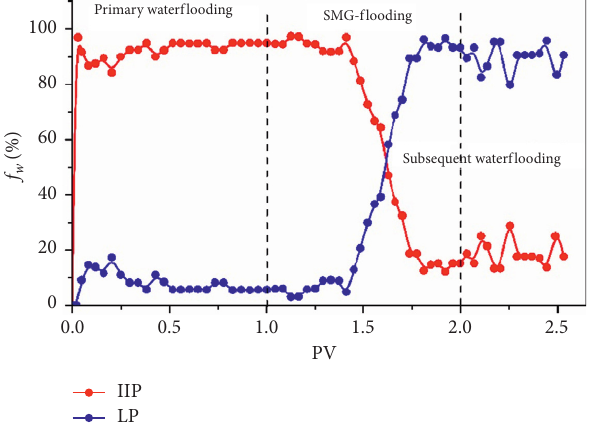
Figure 2: The curve of profile control (fraction flow rate, f